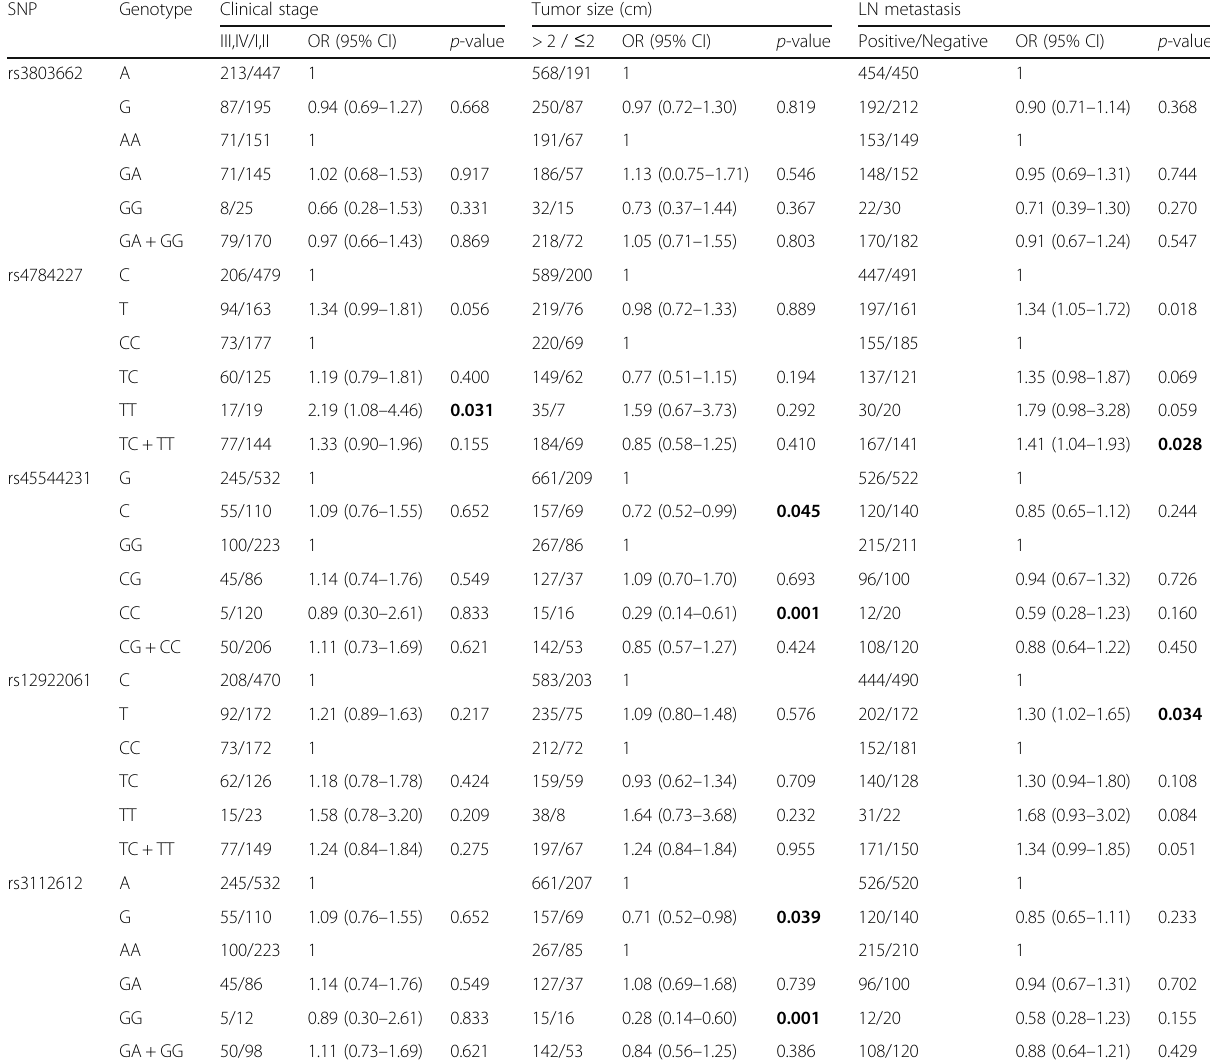
Table 5 Correlations between CASC16 polymorphisms and clinical characteristics of patients with breast cancer (adjusted by